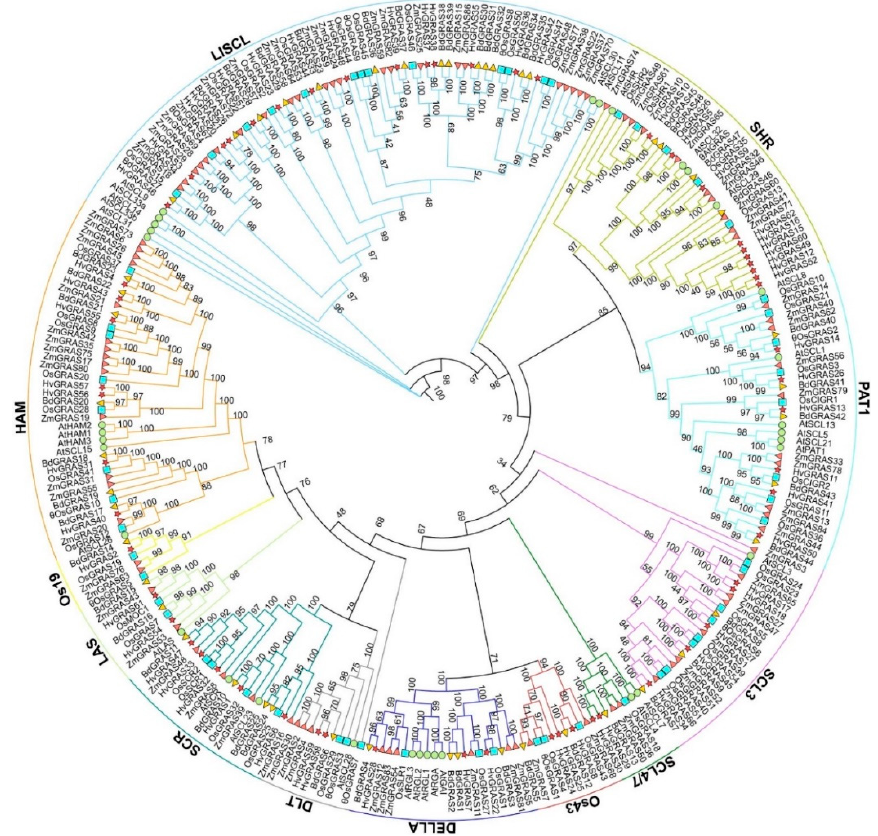
Figure 1. An unrooted phylogenetic tree of GRAS transcription factors. The phylogenetic tree (Maximum Likelihood) of GRAS proteins including Arabidopsis (green), rice (blue), maize (orange), barley (red), and Brachypodium distachyon (yellow) were generated. “ θ ” indicates for the pseudogene fragments.